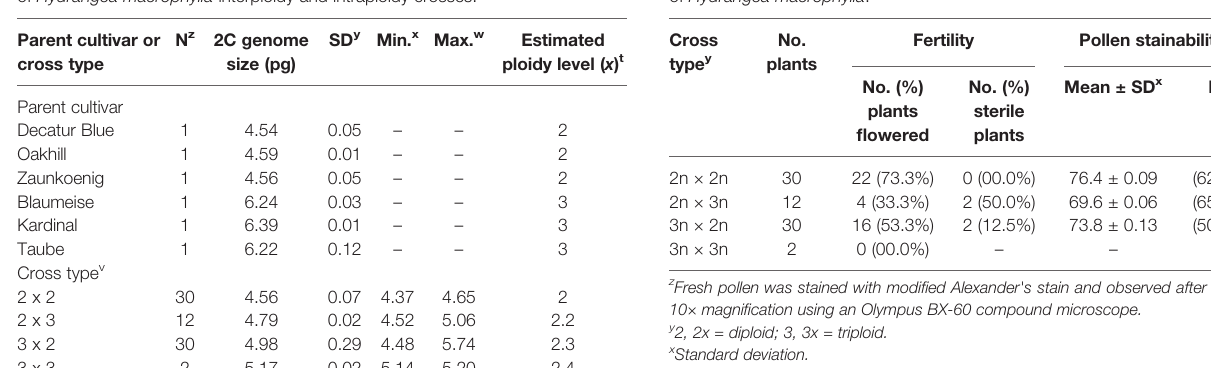
TABLE 5 | Pollen stainability of offspring from intraploidy and interploidy crosses of Hydrangea macrophylla